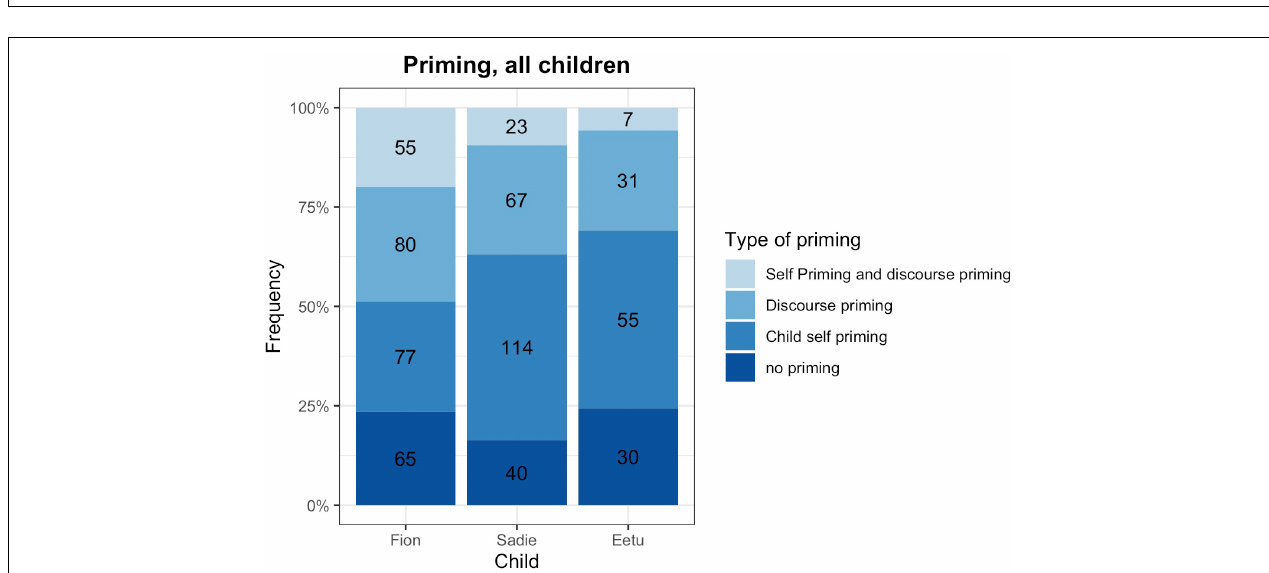
FIGURE 2 | Priming in lexically specific patterns. Numbers in the bars indicate the number of cases.